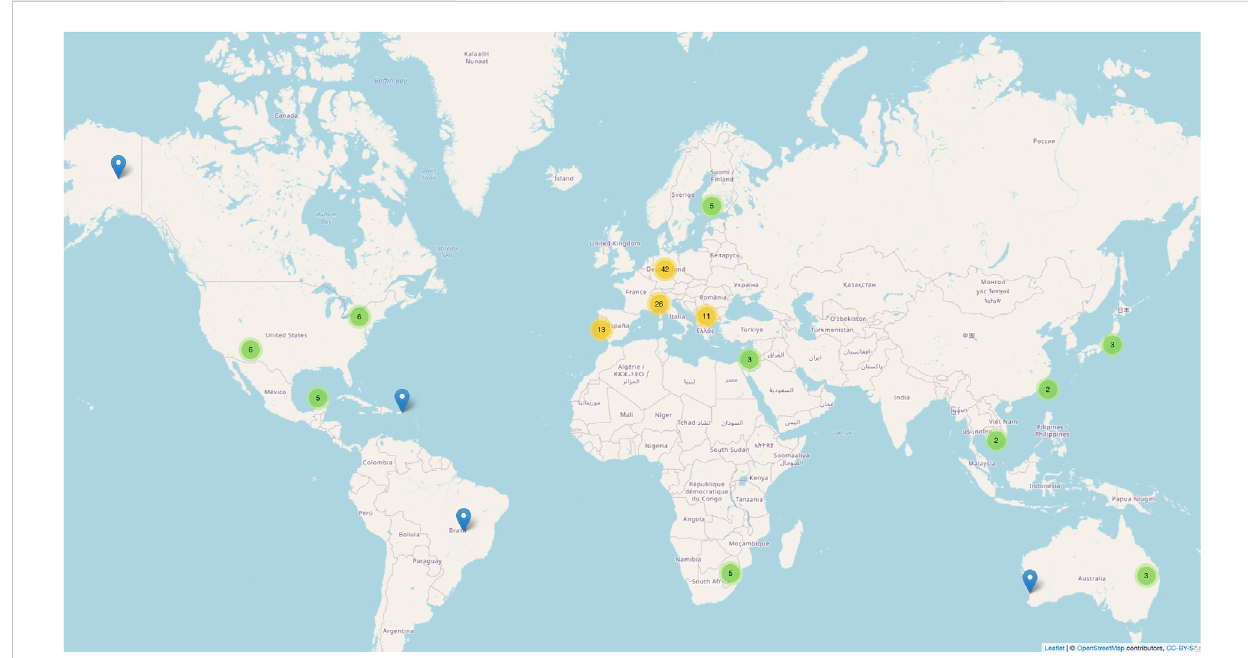
FIGURE 1 Map of the distribution of respondents by biogeographic regions [© OpenStreetMap contributors (openstreetmap.org). Map data July 14, 2023].